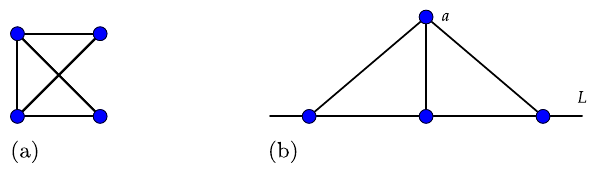
Figure 2: A near - quadrangle and a near - pencil in a con fi guration. ( a ) Near quadrangle, ( b ) near -